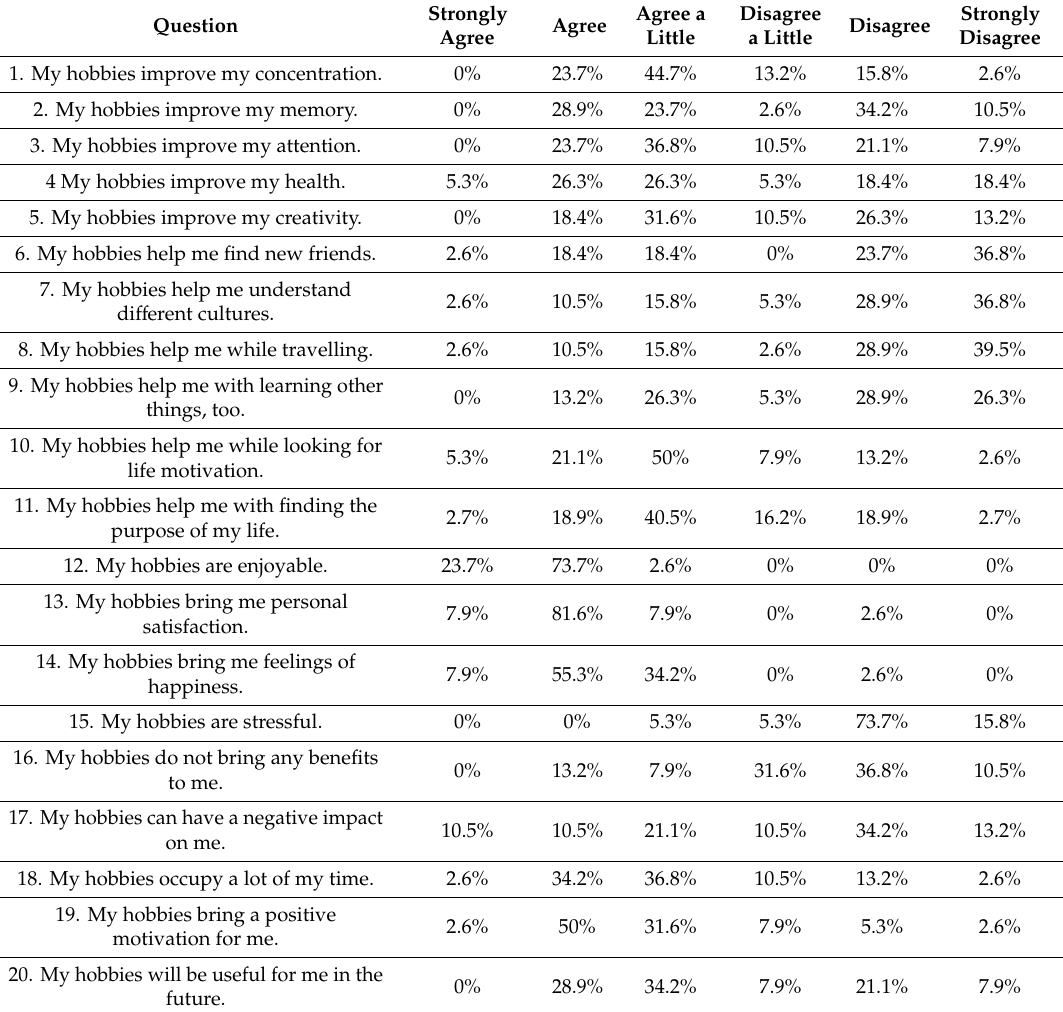
Table 3. An overview of the questionnaire results of the elderly control group. Question